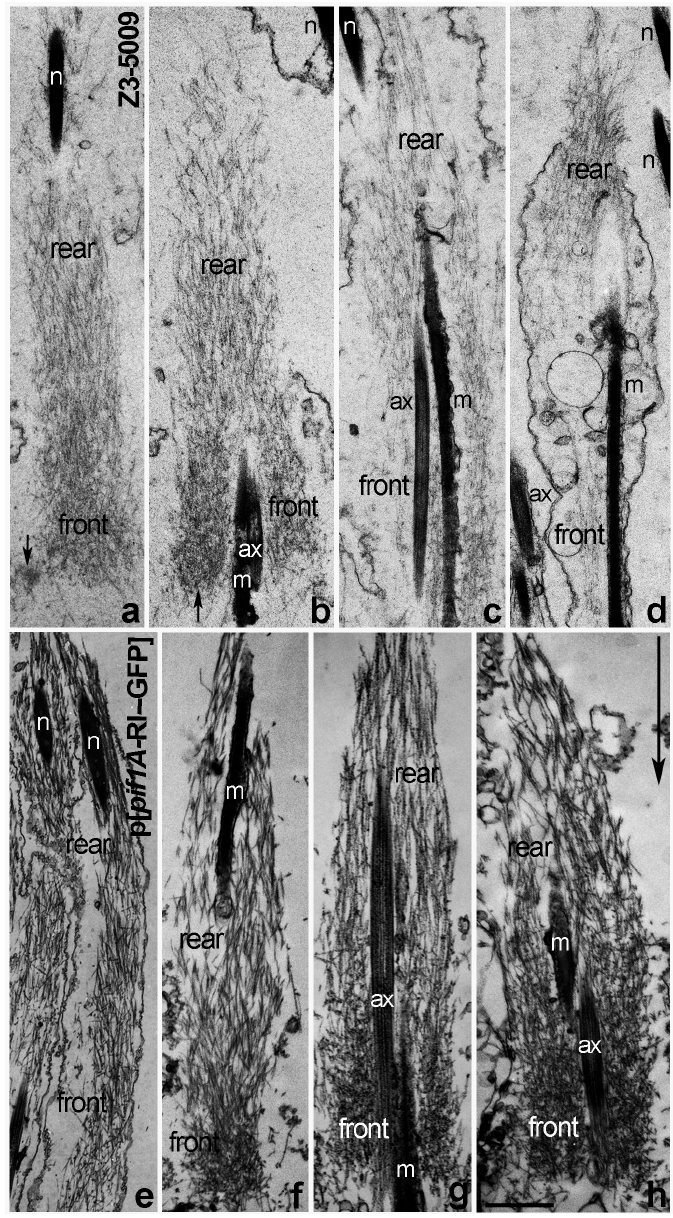
Figure 6. Longitudinal sections of S1-decorated Z3-5009 actin cones vs. cones from flies that express the Pif1A-RI-GFP transgene. Mutant actin cones ( a – d ) are composed of much shorter and thinner actin filaments than the WT cones (Figure 6a–d vs. Figure 5a–d). Newly forming Z3-5009 cones contained mainly parallel bundles of actin ( a ). Some of the mutant cones, which appeared to move slightly away from the spermatid nuclei ( b ), have disturbed structure with a bigger front meshwork and less organized rear region of parallel bundles than in WT early cones (Figure 6b vs. Figure 5b,c). Arrows in ( a , b ) indicate an abnormal actin meshwork that is denser on only one side of the early Z3-5009 cones. Most of the later mutant actin cones are disorganized ( c , d ). Longitudinal sections of actin cones from flies that express the Pif1A-RI-GFP transgene and are homozygous for Z3-5009 (p[Pif1A-RI-GFP/CyO3; Z3-5009/Z3-5009]) show that the Z3-5009 phenotype is rescued—the cones form and assemble actin properly during spermatid individualization ( e – h ). Arrow in h indicates the direction of actin cone movement during individualization. Bar 1 µm.